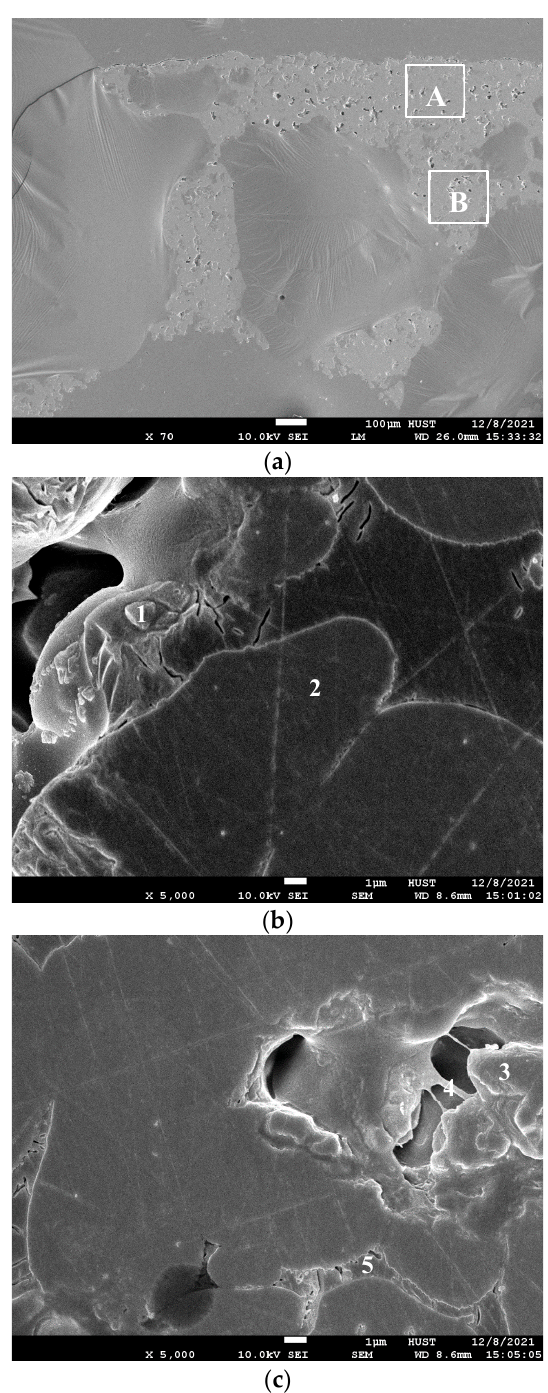
Figure 7. SEM image of the cross section of the coating after oxidation. ( a ) Whole SEM image; ( b ) Locally amplified SEM image at area A in ( a ); ( c ) Locally amplified SEM image at area B in ( b ). A, B represent different regions in the coating, while 1,2,3,4,5 represent different position points. Table 5. EDS results at different parts of the cross section of the coating after oxidation. Element (at.%)